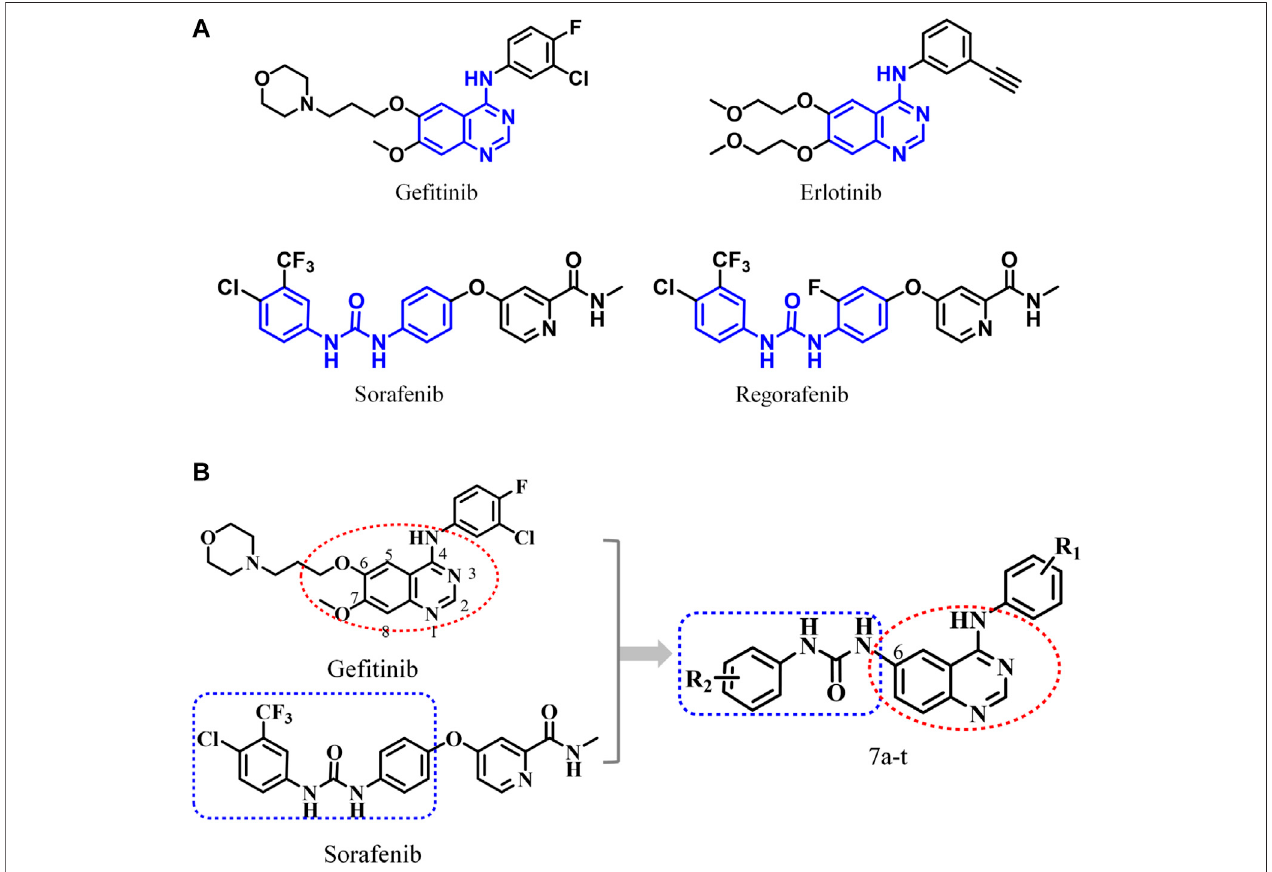
FIGURE 1 | (A) Antitumor drugs with 4-anilinoquinazoline and diaryl urea structural fragments; (B) design scheme of 6-ureido-4-anilinoquinazoline derivatives.